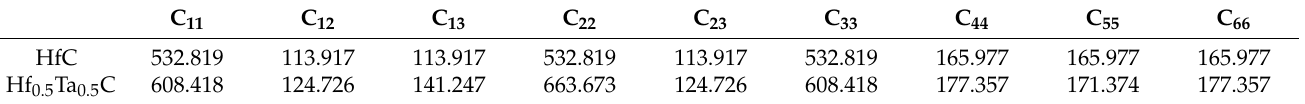
Table 3. The calculated second-order elastic coefficients.